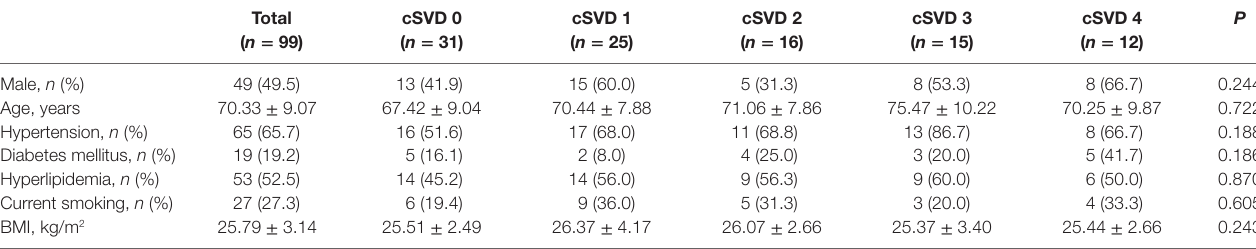
TaBle 1 | Demographic and clinical features of participants with different severity of total MRI cSVD